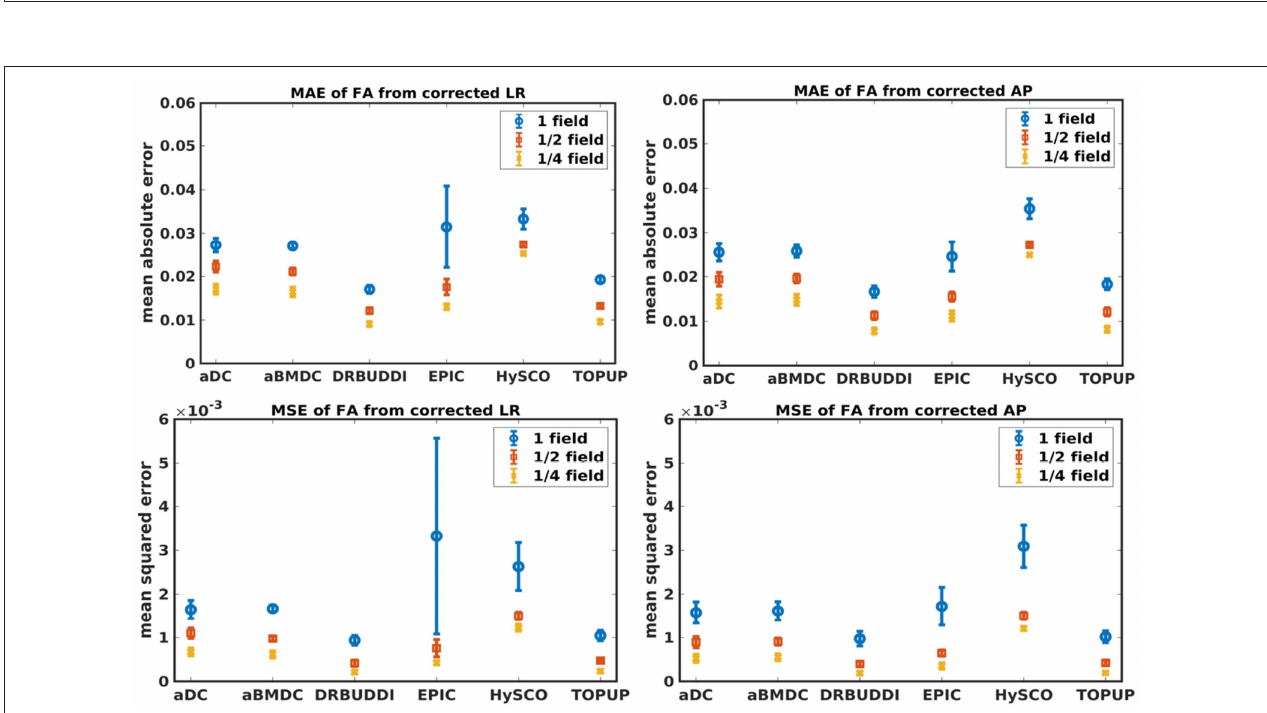
FIGURE 6 | MAE (Top) and MSE (Bottom) of FA for five simulated HCP subjects using the six methods. The error bars represent standard deviation over subjects. Correction was carried out for LRRL (Left) and APPA (Right) pairs, respectively. Three levels of susceptibility distortion were simulated.